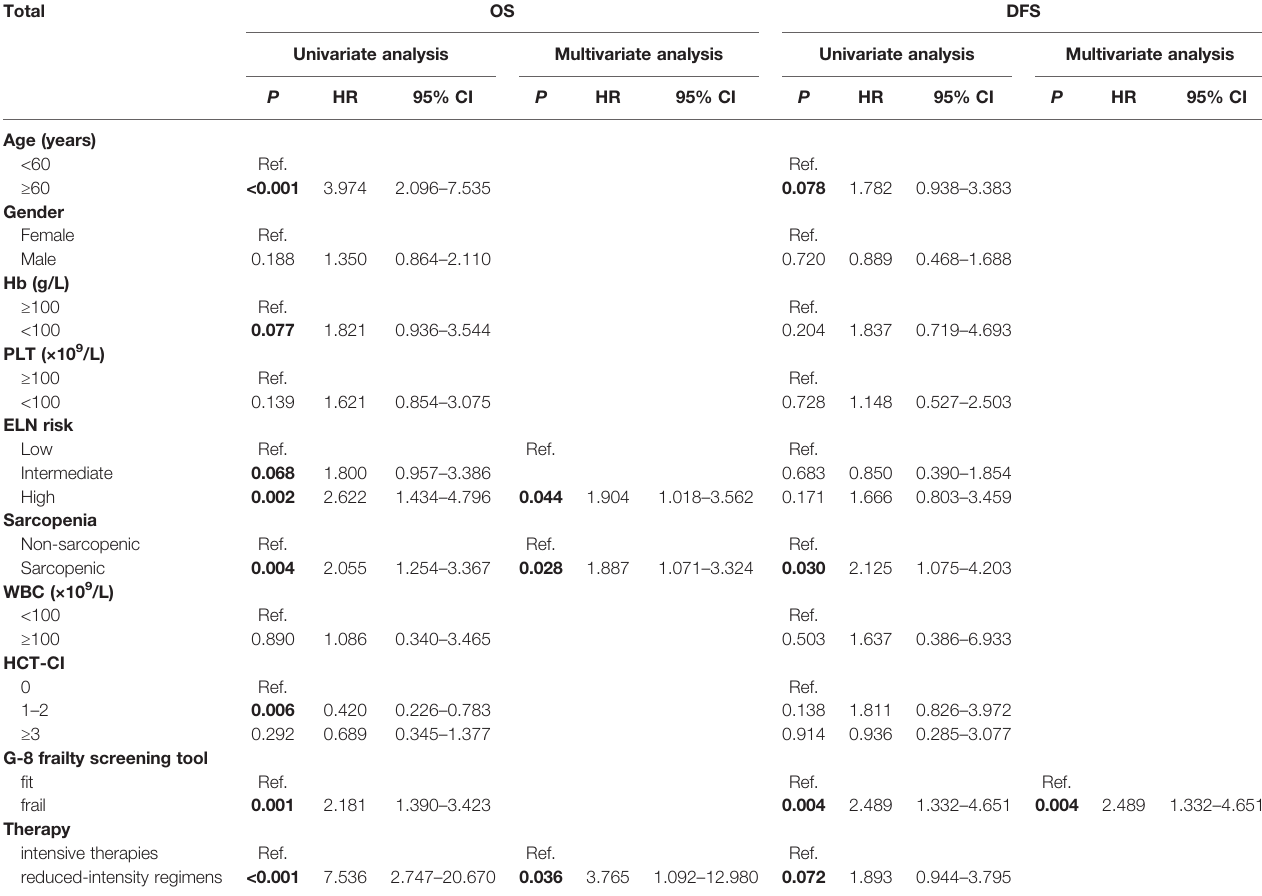
TABLE 4 | Univariate and multivariate analyses for OS and